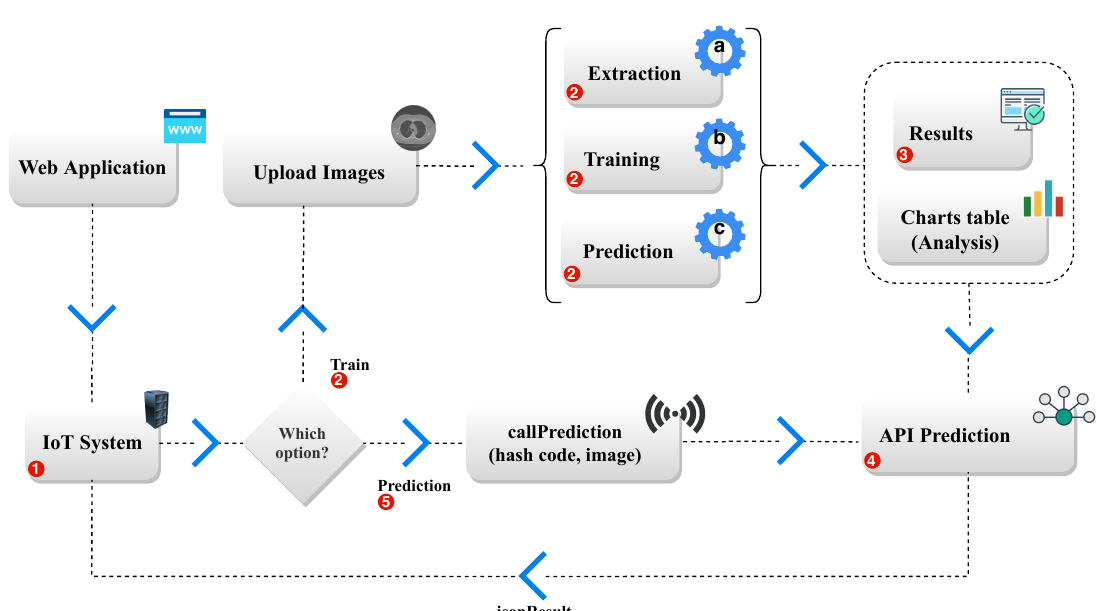
Figure 1. Illustration of the LINDA system architecture. The platform is accessed from